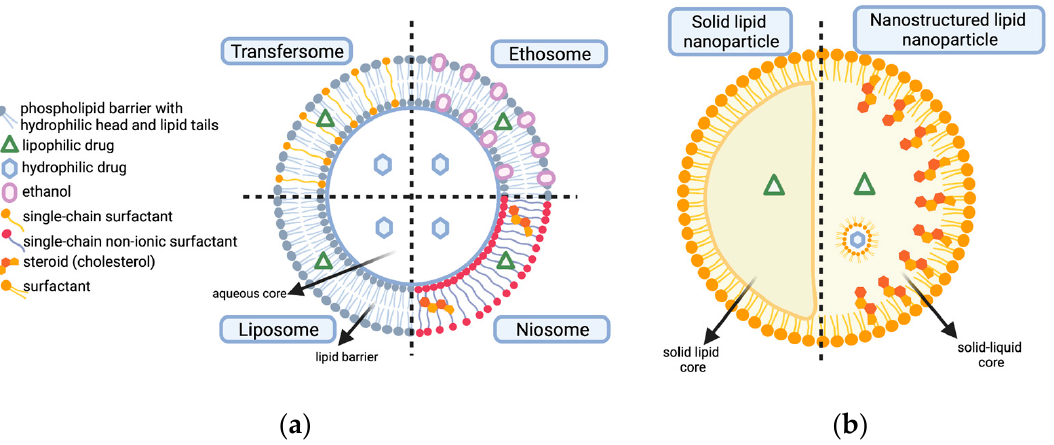
Figure 3. Vesicular ( a ) and particulate ( b ) systems (Illustration created with BioRender [29]). Ethosomes (Figure 3a) are flexible vesicles formed from the combination of phospho- lipids, ethanol, and water, and can solubilize poorly soluble actives [99]. Ethanol, a known penetration enhancer, exhibits synergistic effects with the vesicles and/or skin lipids for improved delivery into the skin [117]. Transfersomes (Figure 3a) are highly deformable vesicles made of phospholipids, surfactants, and water, and are capable of penetrating through the SC into the skin [118] The surfactant, referred to as the edge activator, usually has a single chain and acts as a penetration enhancer by decreasing the bilayer rigidity and enabling the vesicles to remain intact while traversing the SC